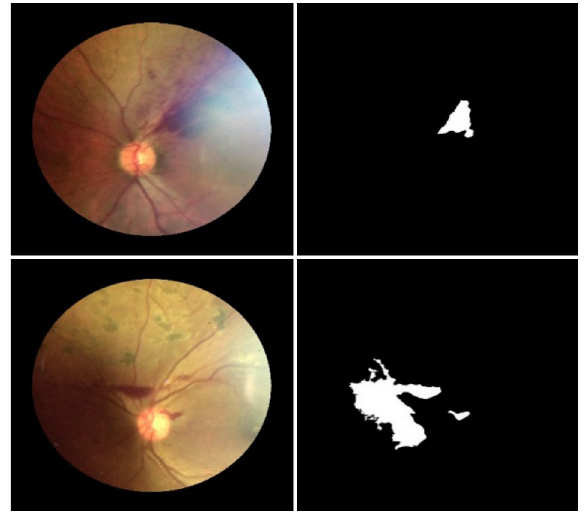
Figure 5. Examples of an undersegment case (top) and an oversegment case (bottom). The original image and the segmented result from KMMRC-INRG are shown on the left and the right,